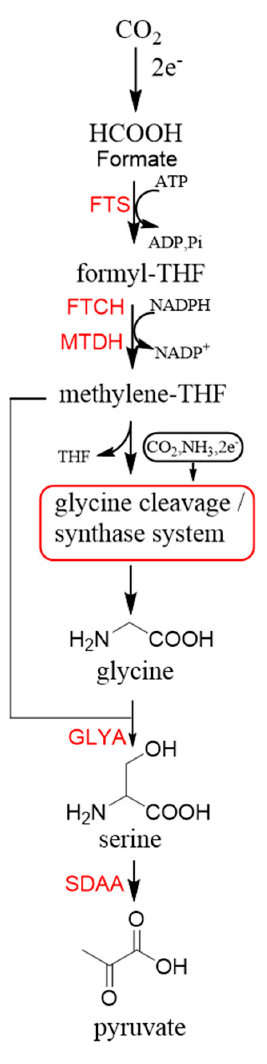
Figure 8. The reductive glycine pathway (RGP) [61]. FTS, formyl-THF synthase; FTCH, formyl-THF cyclohydrolase; MTDH, methylene-THF dehydrogenase; GLYA, L-serine hydroxymethyltransferase; SDAA, L-serine dehydratase.